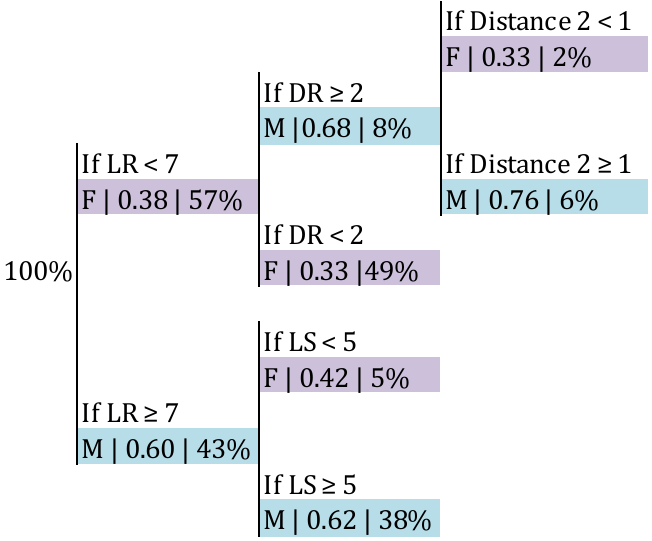
Figure 6. Probability of Category depending on the LR, DR, LS and DS and Distance 2. LR: latitude of the setter in the moment of reception; DR: depth of the setter in the moment of reception.